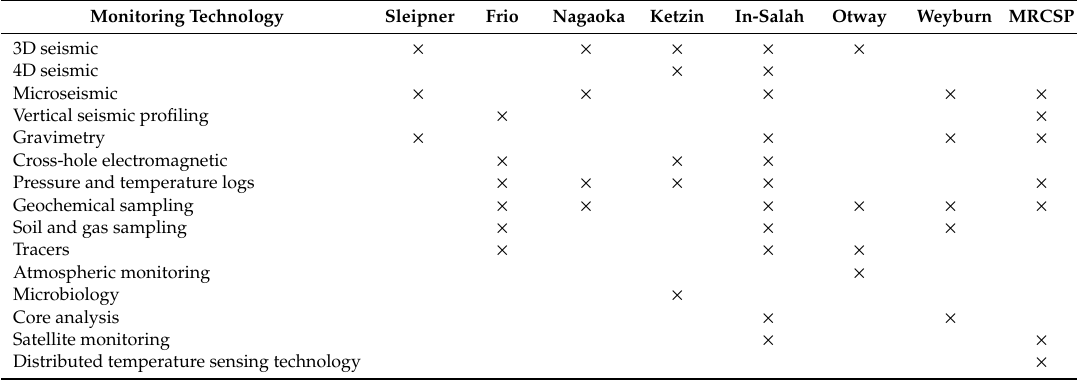
Table 5. Application of the main monitoring technologies in some CCS demonstration projects (modified from